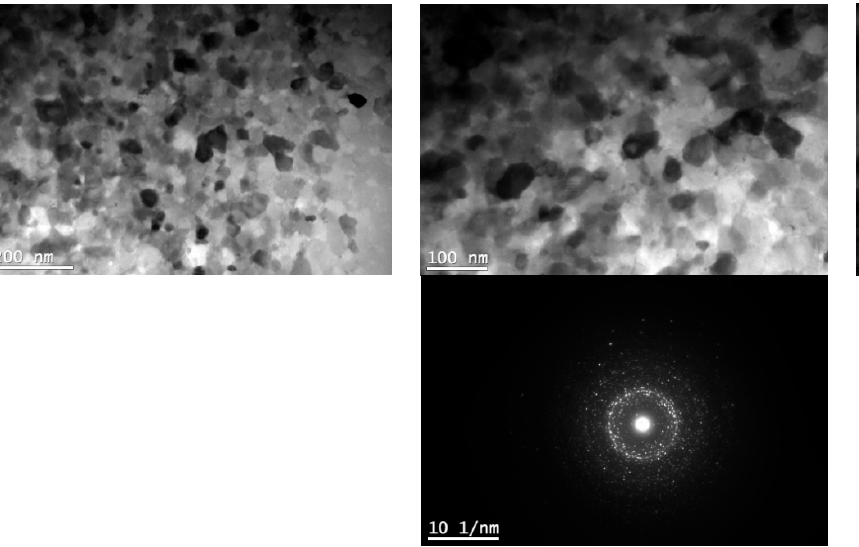
Figure 5. TEM micrograph of Sample 1 and corresponding diffraction pattern.